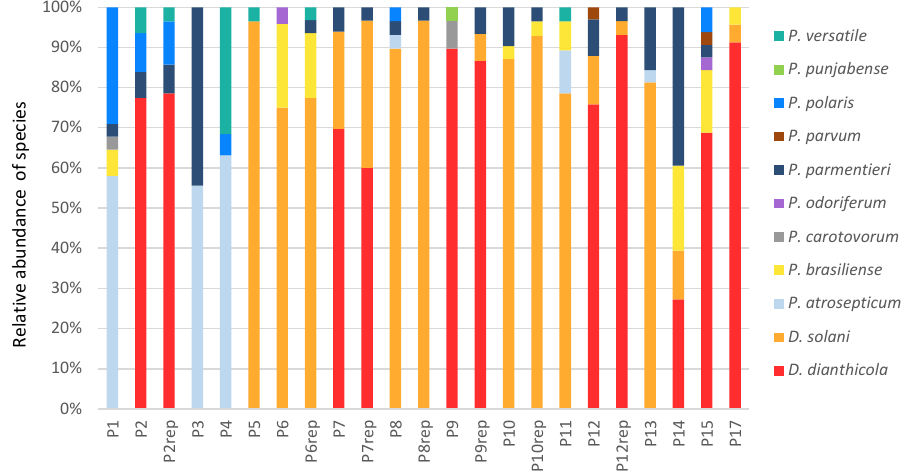
Figure 2. Species patterns in sampled fields and parcels. Relative abundance of species in sampled production fields (P1 to P17) and experimental parcels (P2rep to P12rep).